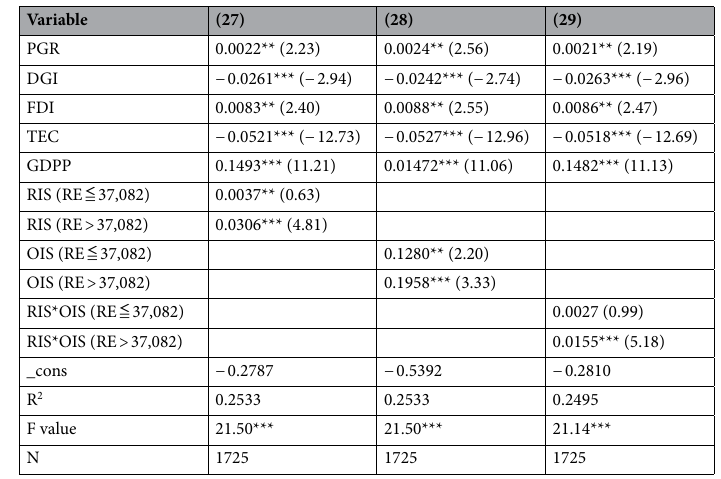
Table 10. Parameter estimation results of panel regression model. * p < 0.1, ** p < 0.05, *** p < 0.01; the bracket represents the t